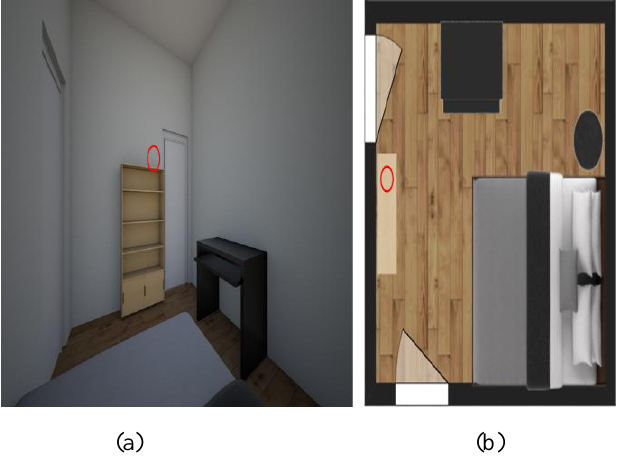
Fig. 5. Floor plan of the environment used for testing, (a) A 3D rendering of the environment, (b) The layout design of